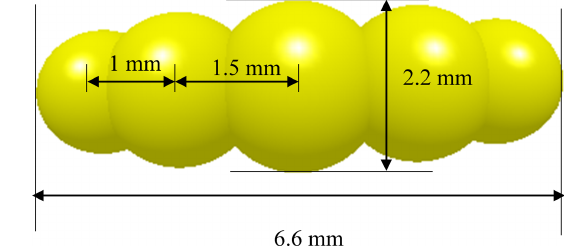
Figure 2. DEM model of a rice particle (Meng et al.,